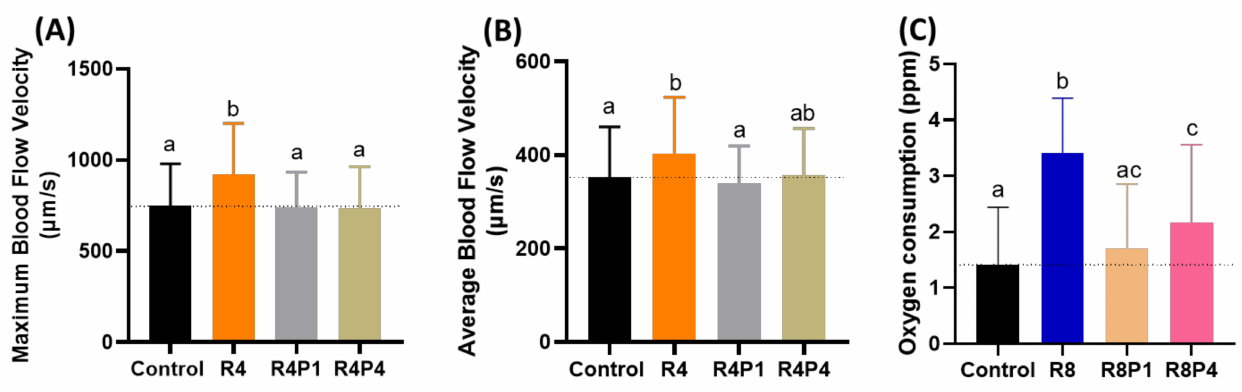
Figure 9. Evaluation of blood flow velocity and oxygen consumption in zebrafish larvae after co-incubating RAC and PROP. ( A ) Maximal and ( B ) average blood flow velocity in the dorsal aorta of zebrafish larvae aged at 72-h post fertilization (hpf) after 24 h incubations in RAC–PROP from 48 hpf onwards. The data are shown as the means ± SEM and were analyzed by One-way ANOVA test with Fisher’s LSD test ( n Control = 41, n R4 = 40, n R4P1 = 20, and n R4P4 = 20). ( C ) Oxygen consumption of zebrafish larvae at 5 dpf after 24-h incubation in different doses of RAC and RAC-PROP combination. The data are shown as the means ± SD and analyzed by One-way ANOVA test with Dunn’s correction as post-hoc multiple comparison test ( n = 42–46). Different letters a, b, and c above columns indicate significant statistical differences with p < 0.05. Abbreviations: R4 (RAC 4 ppm), R4P1 (RAC 4 ppm, PROP 1 ppm), R4P4 (RAC 4 ppm, PROP 4 ppm), R8